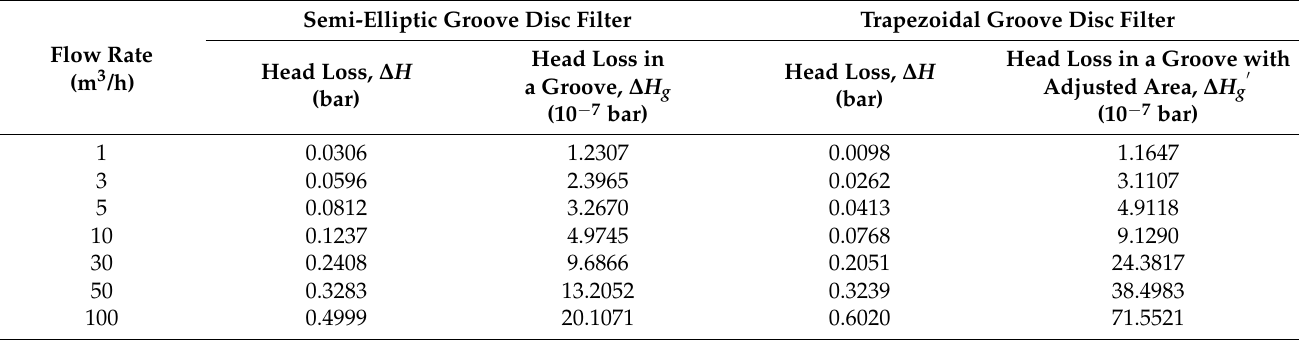
Table 4. Head loss analysis of disc filters considering the adjusted